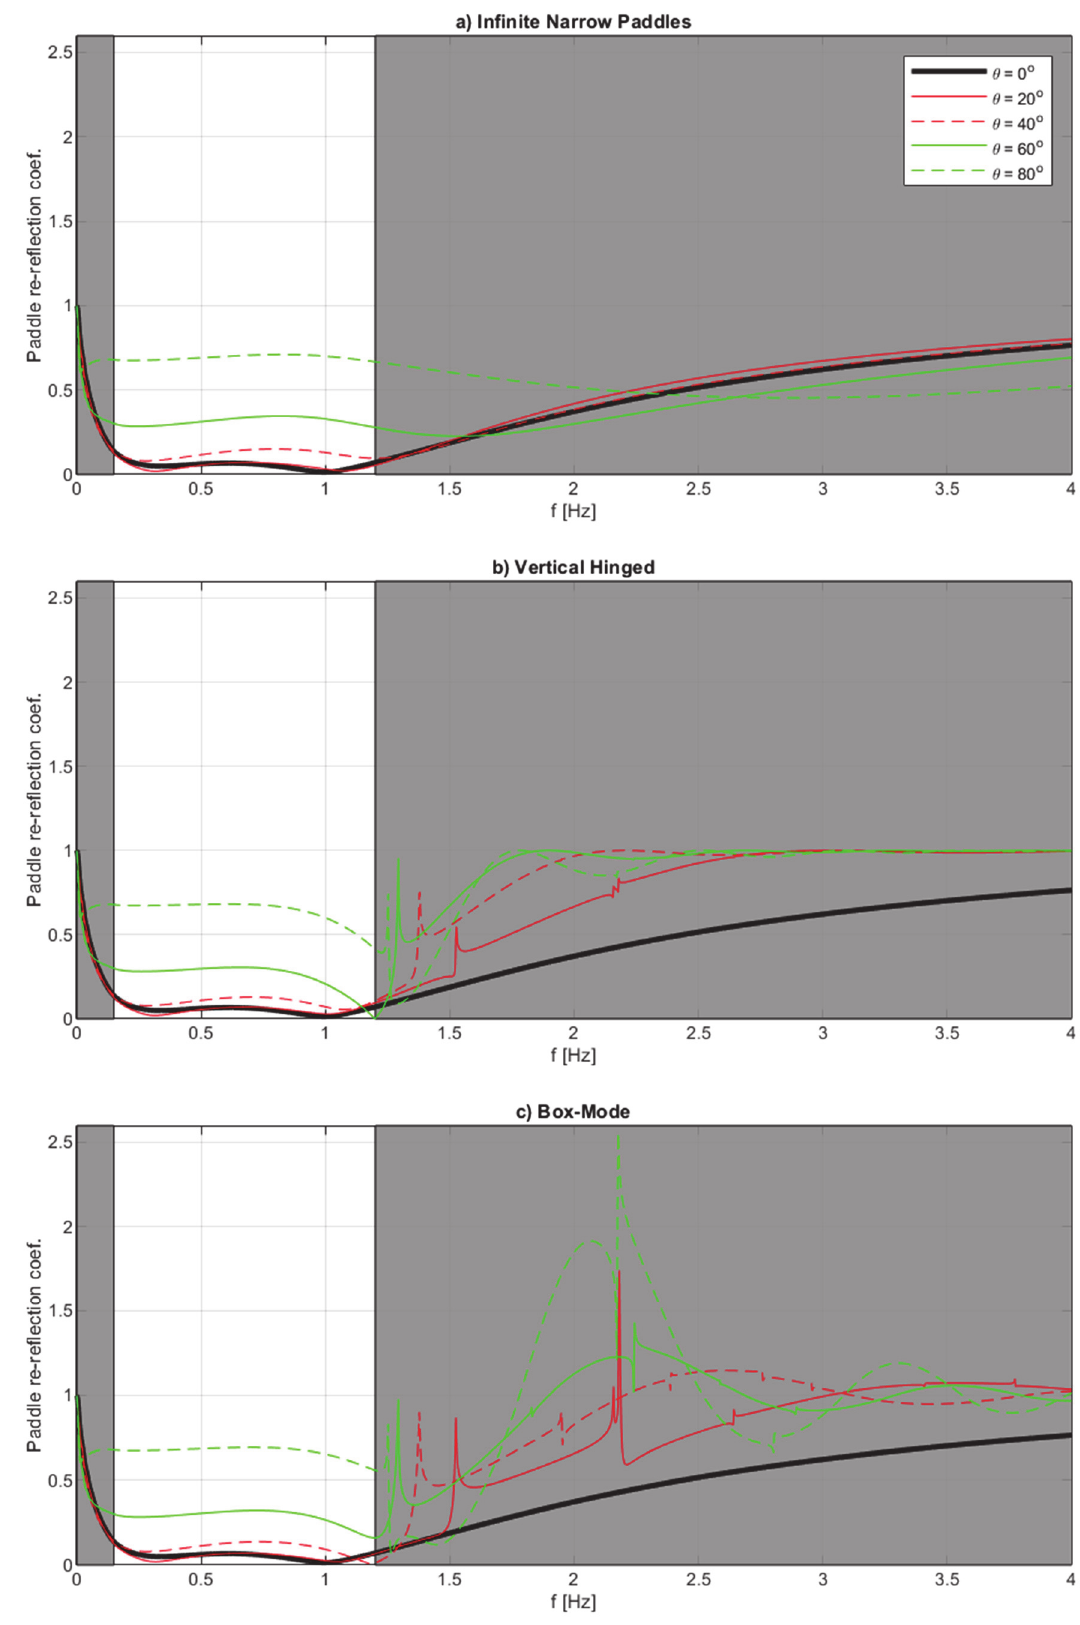
Figure 3. Performance curves in terms of paddle re-reflection coefficient as a function of frequency and obliquity of the wave to be absorbed. Example for a water depth of h = 0.65 m and flush mounted gauges ( d wg = 0). ( a ) Infinitely narrow paddles; ( b ) Vertical hinged pistons with segment widths of l p = 0.5 m.; ( c ) Box-mode pistons also with l p = 0.5 m.